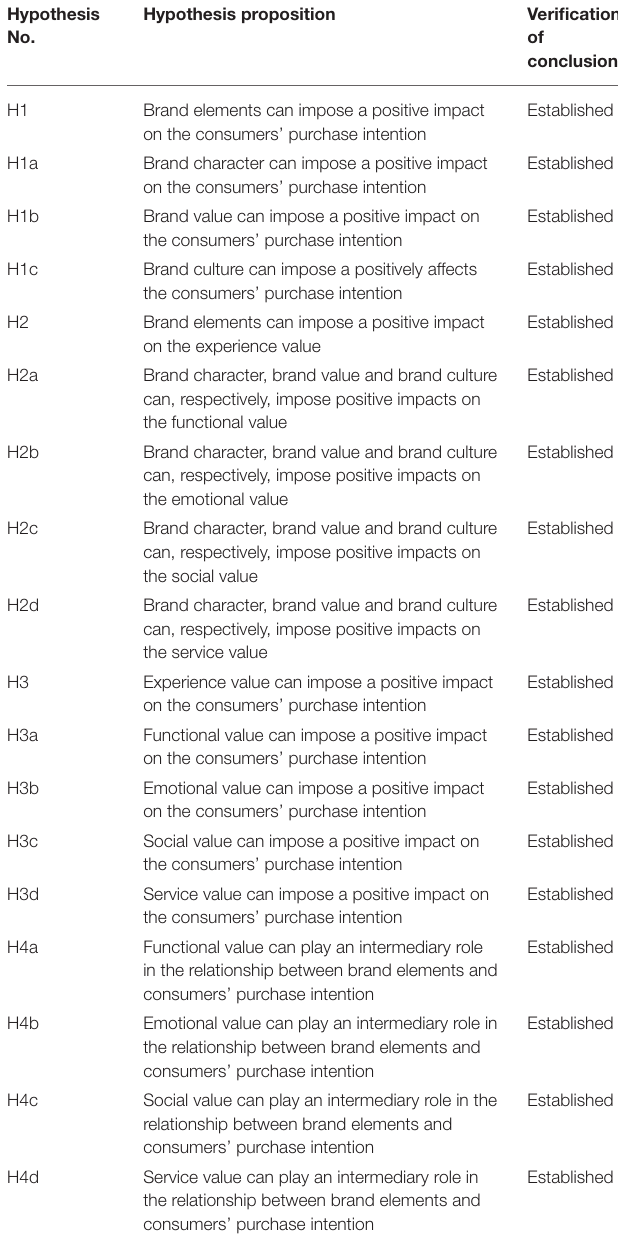
TABLE 15 | Experimental results of research hypotheses. Hypothesis